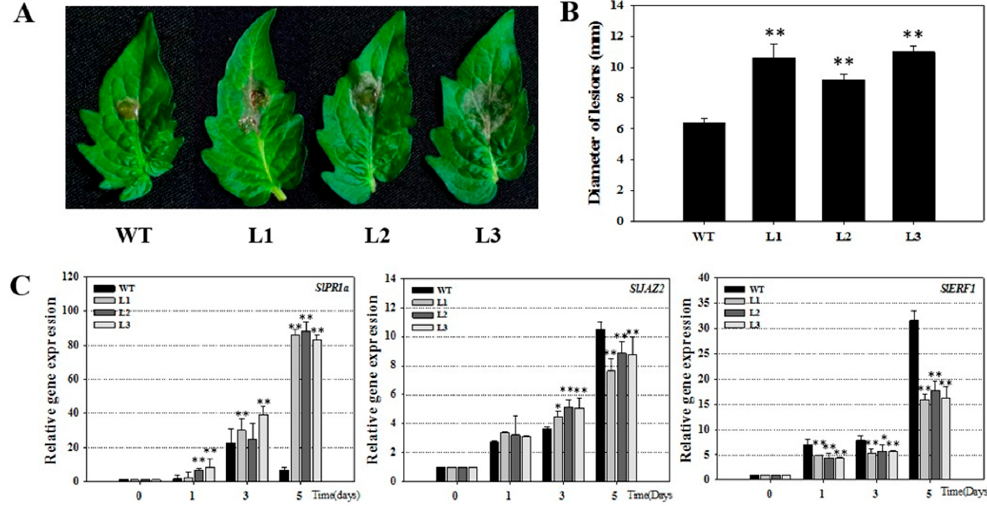
Figure 4. The assessment of VqSTS36 transgenic tomato lines subjected to Botrytis cinerea . ( A ) The symptoms of the transformed tomato and an untransformed one subjected with B. cinerea after 4 days. ( B ) Statistics of lesions’ diameter. ( C ) Relative expression levels of defense-related genes in leaves collected at 0, 1, 3 and 5 dpi. Data represent mean values ± SD from three independent experiments. Asterisks indicate significant differences between WT and transgenic lines as determined by Student’s t -test (* 0.01 < p < 0.05, ** p < 0.01).